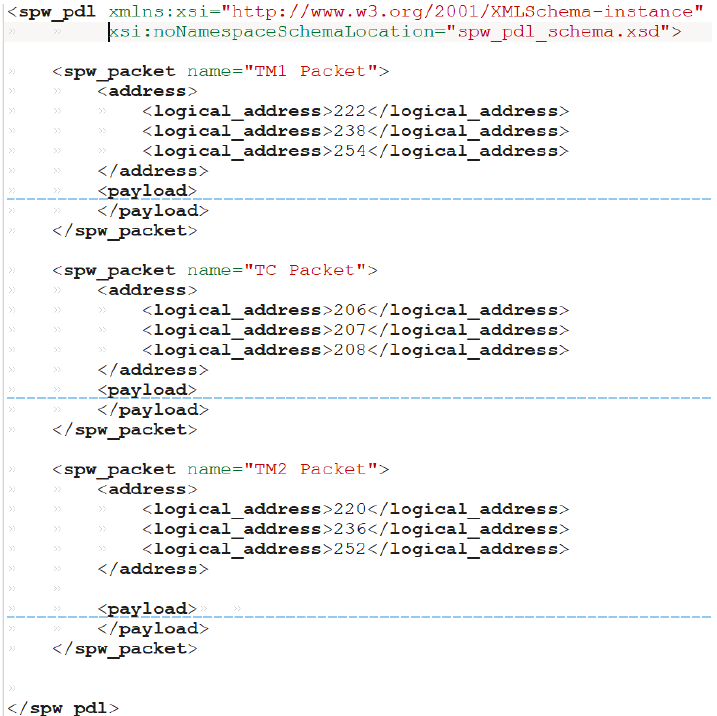
Figure 11. XML packet description of TM1, TM2, and TC packets overview, in compliance with SpW Packet Description Language (PDL)